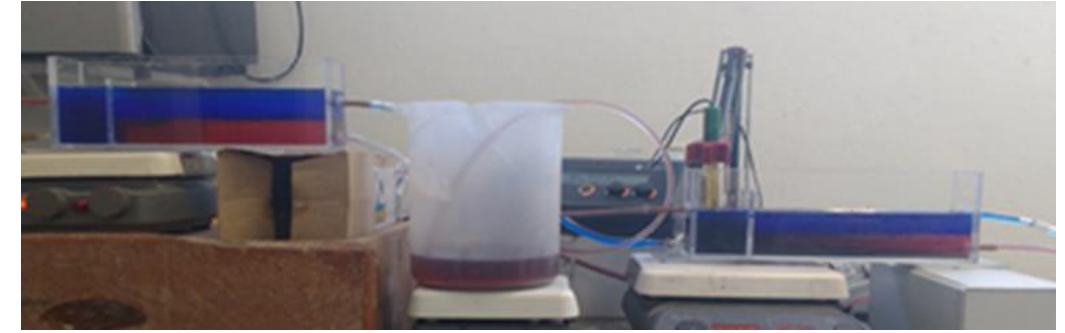
Figure 11. Extraction of cobalt in the continuous mixer-settler.